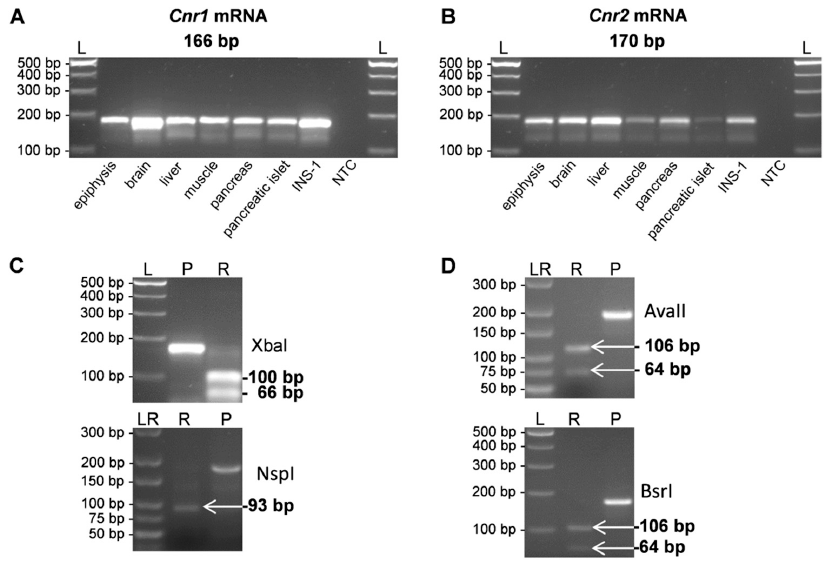
Figure 1. ( A , B ) RT-PCR products of cannabinoid receptors after gel-electrophoretic separation on 3% agarose gels, providing evidence that the transcripts were present in different organs. Molecular sizes of the respective PCR products Cnr1 ( A ) and Cnr2 ( B ) are indicated relative to a molecular size standard (L); ( C ) Restriction digestion of the receptor transcript Cnr1 (P) using the restriction enzyme Xbal shows the predicted restriction fragments of 100 bp and 66 bp (R). After application of the restriction enzyme NspI a fragment with the predicted length of 93 bp becomes visible (R). Please note that smaller fragments (14 bp, 22 bp, and 37 bp) are not seen; ( D ) Restriction fragments of the Cnr2 receptor product (P) after incubation with the restriction enzymes AvaII or BsrI predicted lengths of 64 bp und 106 bp (R) are detected, respectively. NTC, non-template control; L, 100-bp ladder; LR, low range ladder.